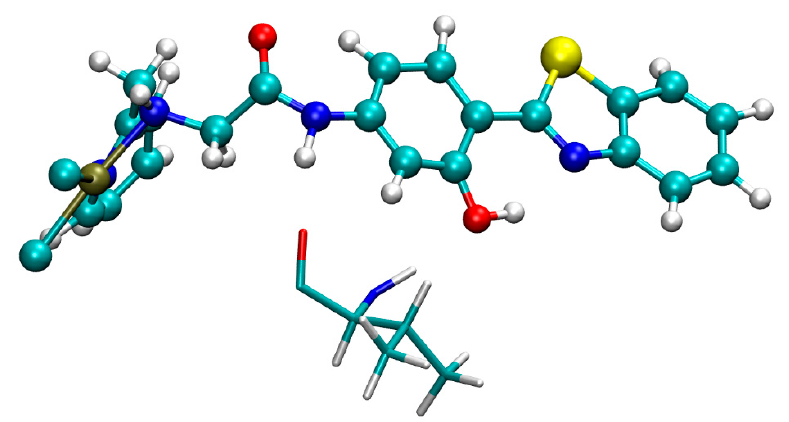
Figure 9. Reduced system of PC:PI3K used for NMR calculations, considering the platinum complex and the Val882 residue. Table 1. Theoretical 195 Pt chemical shifts in different chemical environments performed at theory level